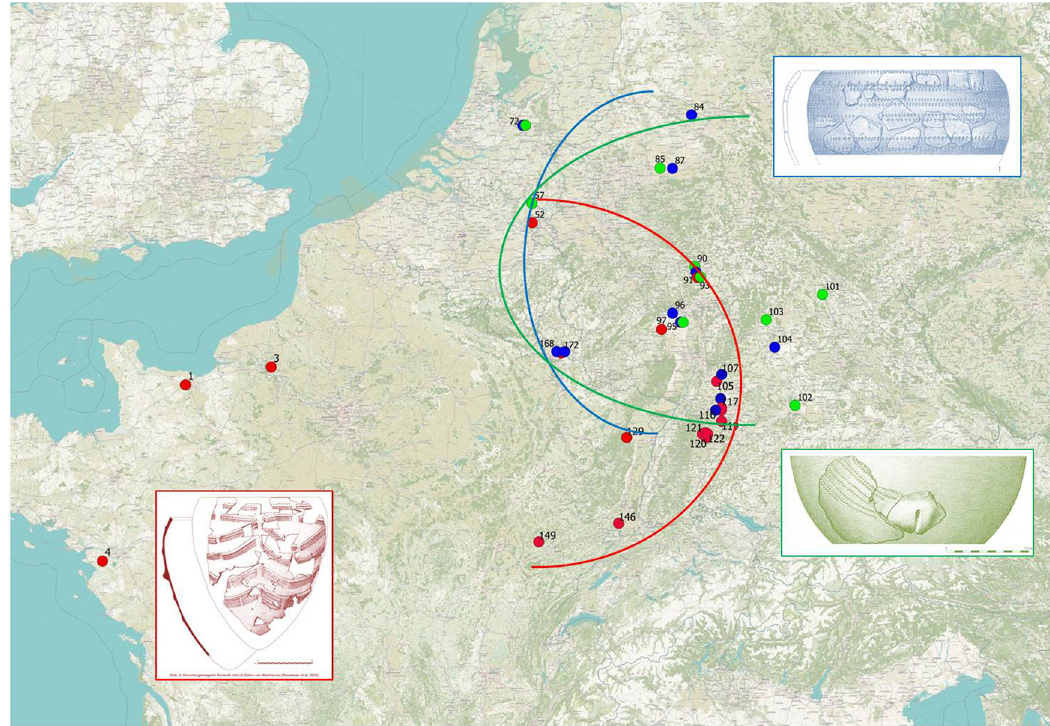
Figure 2: Distribution areas of early bone - , organic - , and mineral - tempered Non - LBK pottery. Examples from Machecoul ( red, left ) , Goddelau ( green, top right ) , and Anröchte ( blue, bottom right ) . ( Drawing: Author with fi gures from Lüning et al., 1989, p. 398, Figure 12.10, p. 414, Figure 28.1; Rousseau et al., 2015, p. 24 ) .